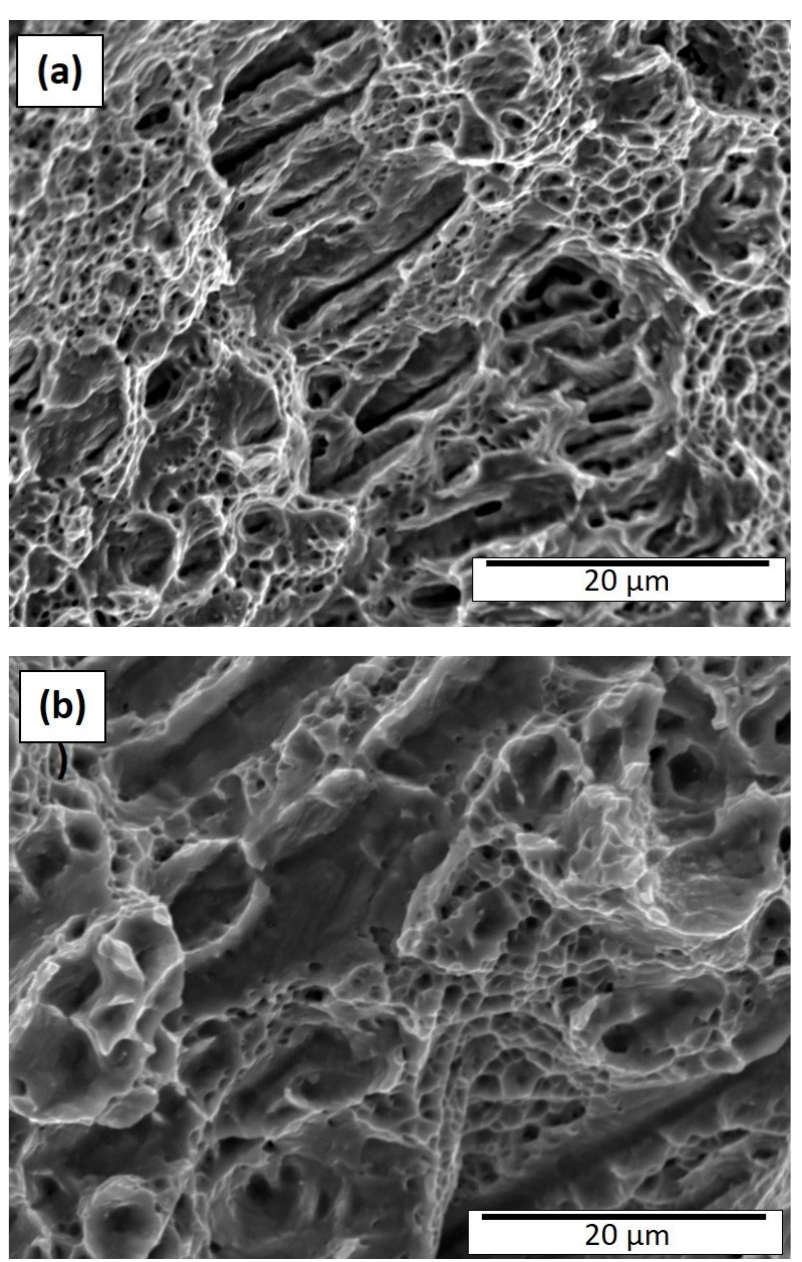
Figure 7. As-built fracture surface (SEM). ( a ) 50 µm layer thickness; ( b ) 100 µm layer thickness.